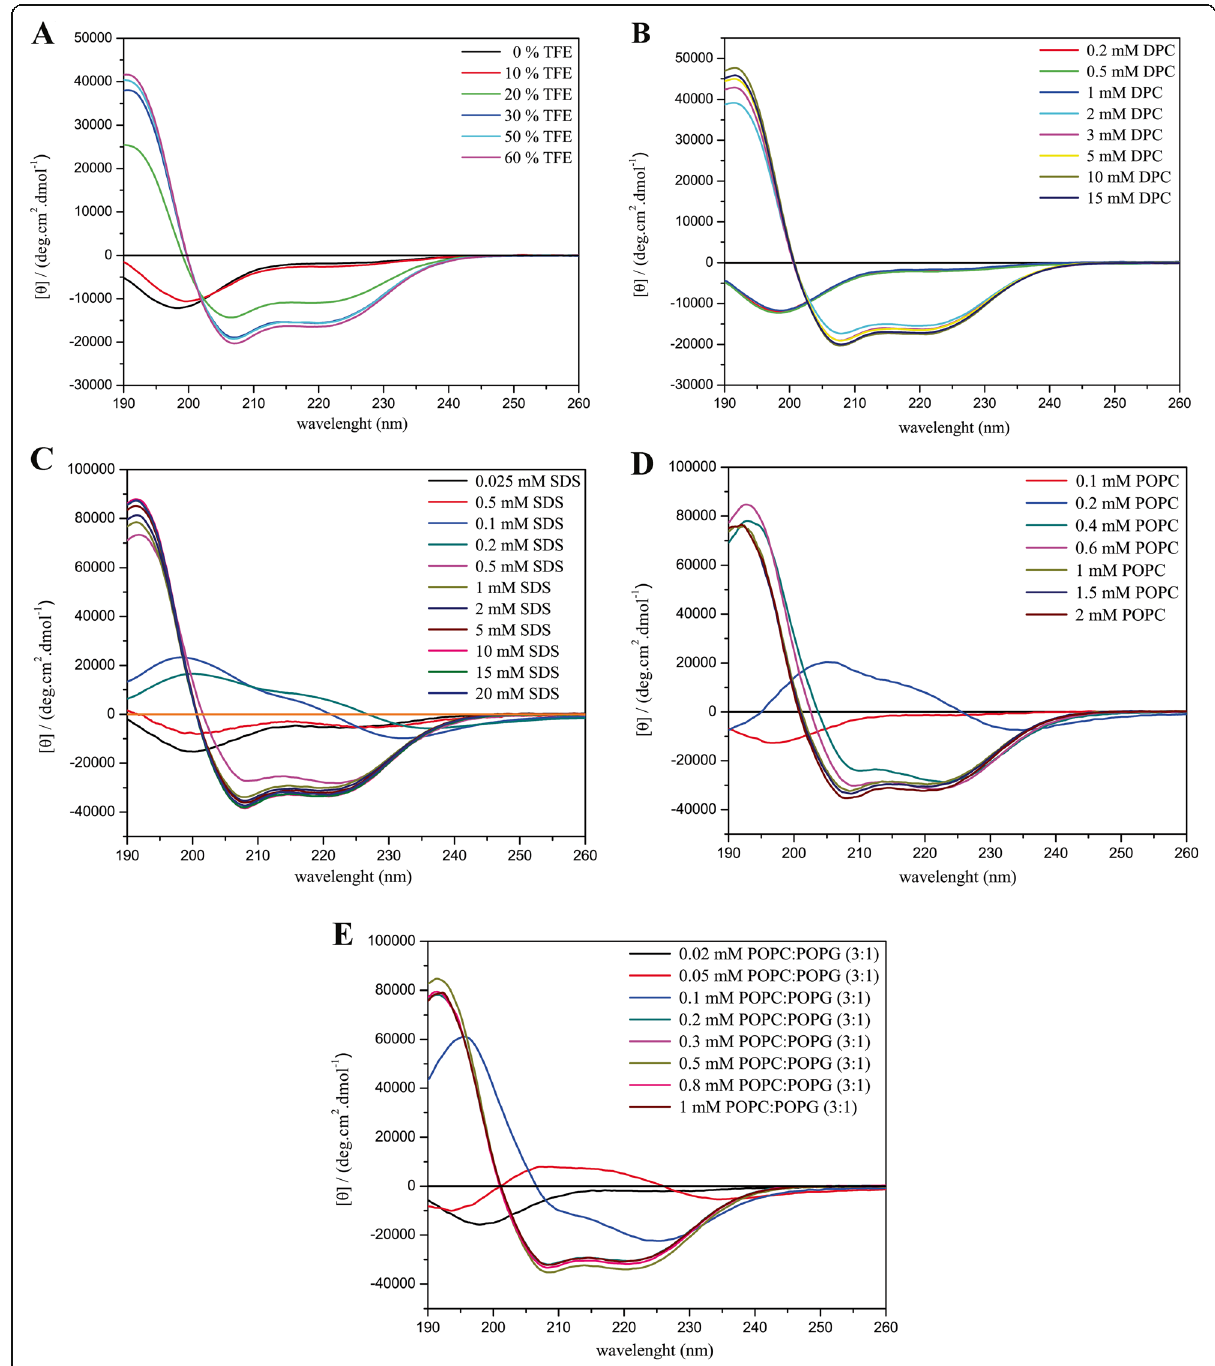
Fig. 7 CD spectra of ocellatin-F1 in the presence of ( a ) TFE:H 2 O solutions, ( b ) DPC and ( c ) SDS micelles, ( d ) POPC and ( e ) POPC:POPG (3:1)